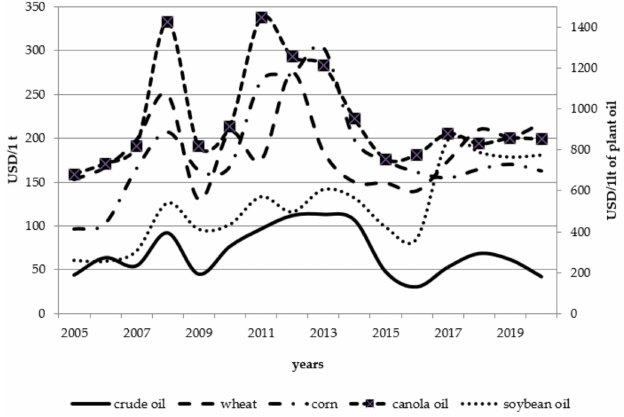
Figure 1. Prices of crude oil and some agricultural raw materials used for the production